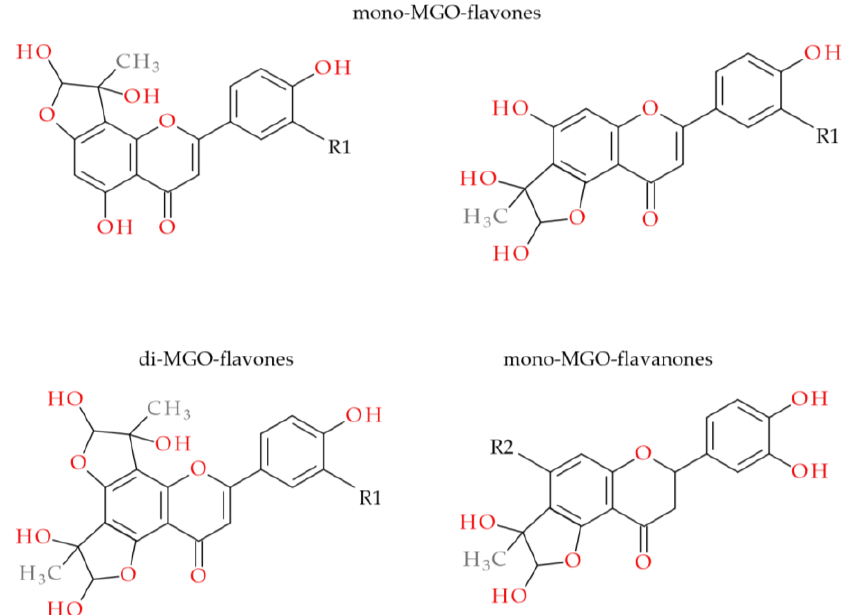
Figure 4. Proposed hemiacetal structures of mono-MGO and di-MGO adducts of luteolin (R1, -OH), apigenin (R1, -H), eriodictyol (R2, -OH) and eriocitrin (R2, -O-rutinoside).